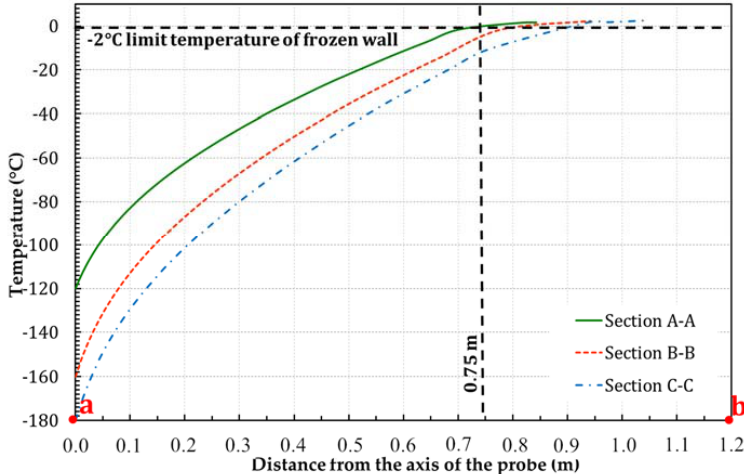
Figure 13. Temperature profile after 14 days of artificial ground freezing (AGF) with liquid nitrogen along the segment a ‐ b.